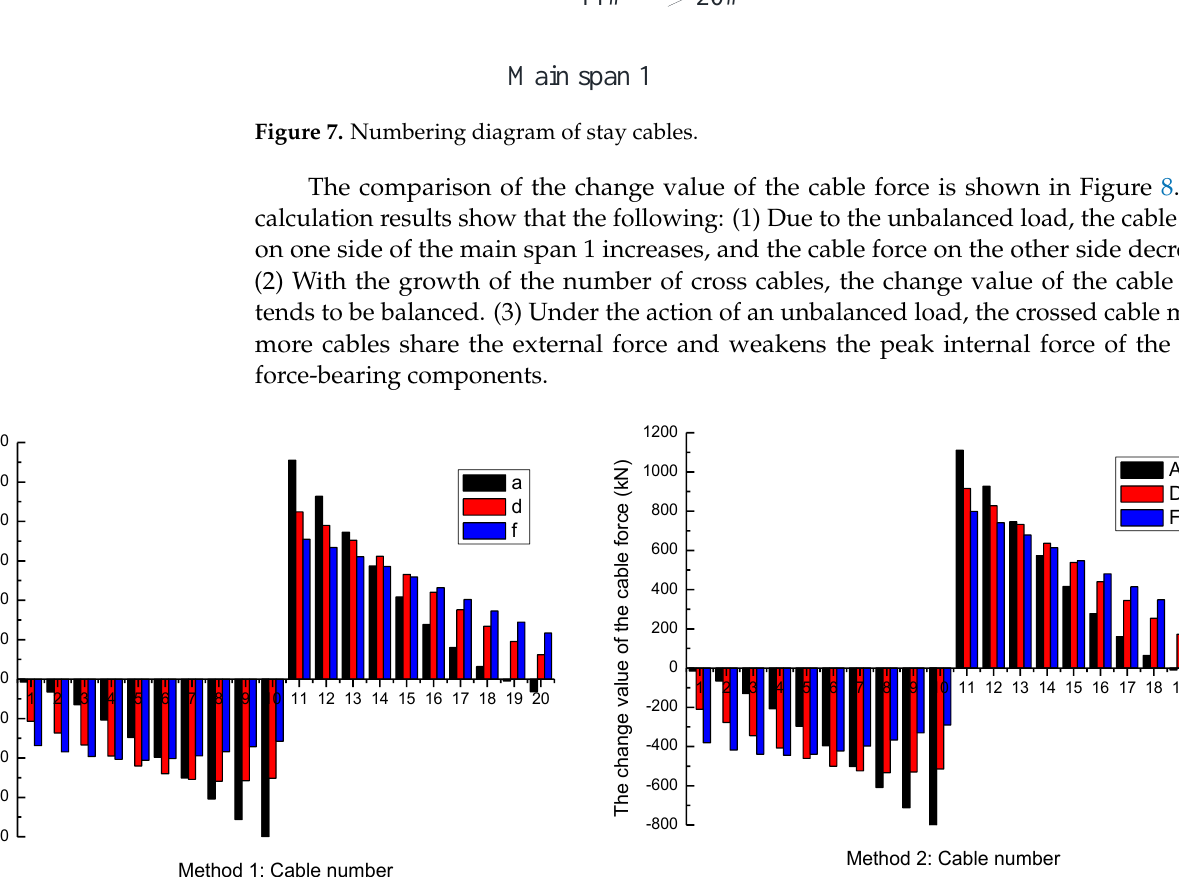
Figure 8. Comparison of the change value of the cable force.In the same set of six pairs of cross cables, when the unbalanced load is q = 50 kN/m, the cable force of the 11#